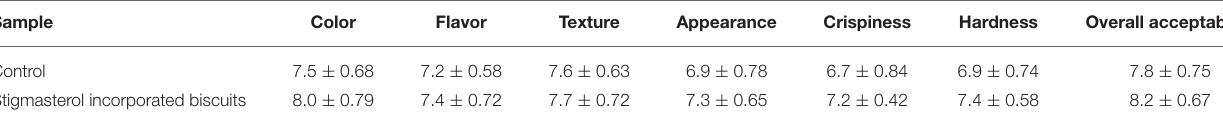
TABLE 1 | Comparison of sensory evaluation results of the stigmasterol incorporated and control biscuits. Sample Color Flavor Texture Appearance Crispiness